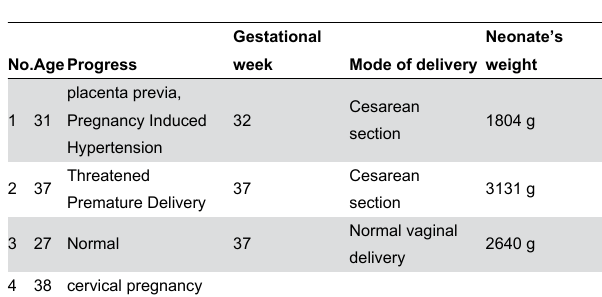
Table 3. Course of pregnancy in patients who underwent NBCA during the peripartum period and later became pregnant.